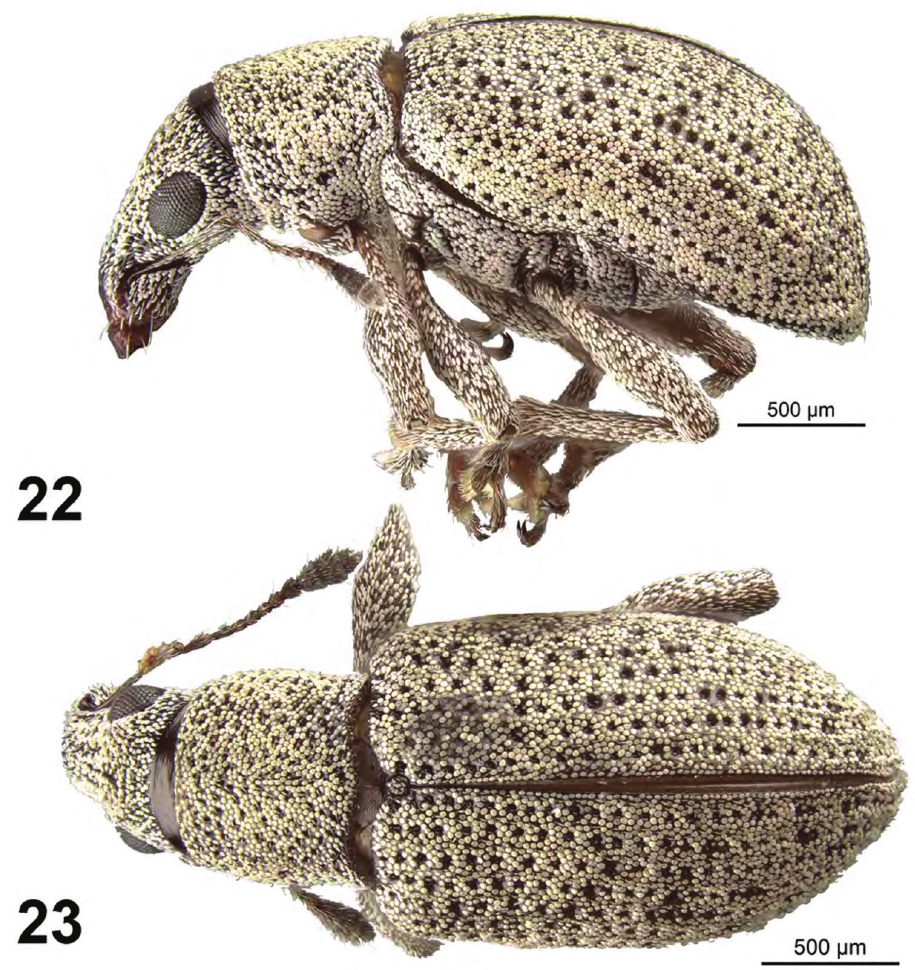
Figures 22–23. Apodrosus sandersoni. 22 Lateral habitus, female 23 Dorsal habitus, female. trum; scrobe curved downwards by 60°, directed posteriorly at end, barely reaching anterior margin of eye, separated from it by about width of scrobe. Mandibles with 2 lateral setae. Antennae reddish brown; antennal scape extending to just slightly before posterior margin of eye; desmomere I very slightly longer than II. Pronotum cylindri- cal, slightly wider than long, greatest width from midlength to base; dorsal surface shallowly punctate, scales moderately dense, each puncture with a suberect, fine grey seta; posterior margin slightly bisinuate, slightly wider than anterior margin; scutellum subcircular, with a few scattered scales. Mesocoxal cavities about 5 times width of in- tercoxal process. Metasternum with lateral portions tumid, not posteriorly produced. Elytra in dorsal view 1.6 times their greatest width; anterior margin sinuate; humeral region of elytra 1.5 times width of posterior margin of pronotum; lateral